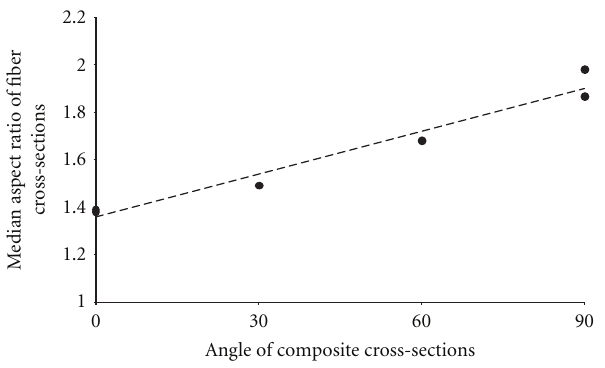
Figure 7: Median aspect ratio of fiber cross-sections as a function of angle of composite